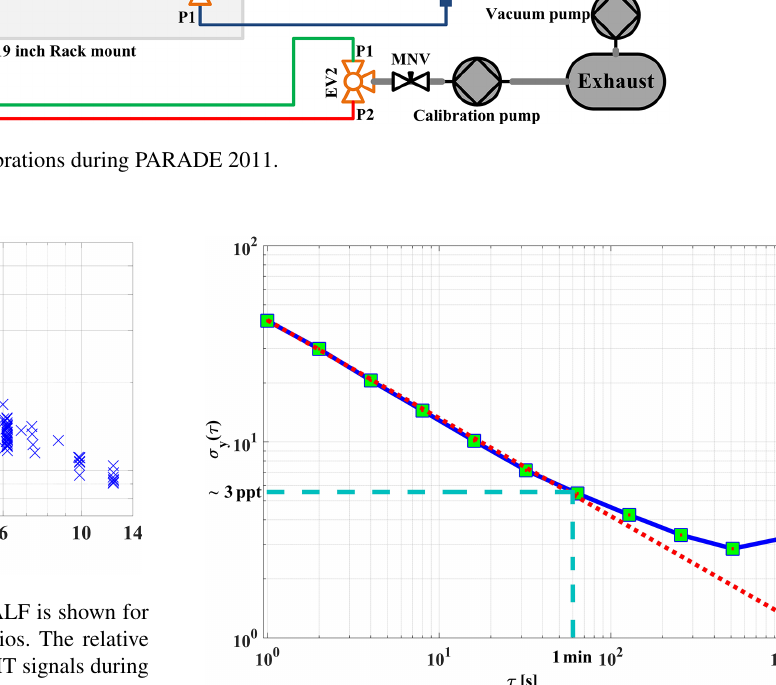
Figure 9. An overlapping Allan deviation plot for the dependence of the 1 σ variation in the background signal vs. integration time. The red dotted line shows the square root dependency of the signal. (Table 1) LOD of GANDALF was calculated using Eq. (4) (Taketani et al., 2007) at a signal-to-noise ratio SNR of 2 and considering the background signal that is 2 times